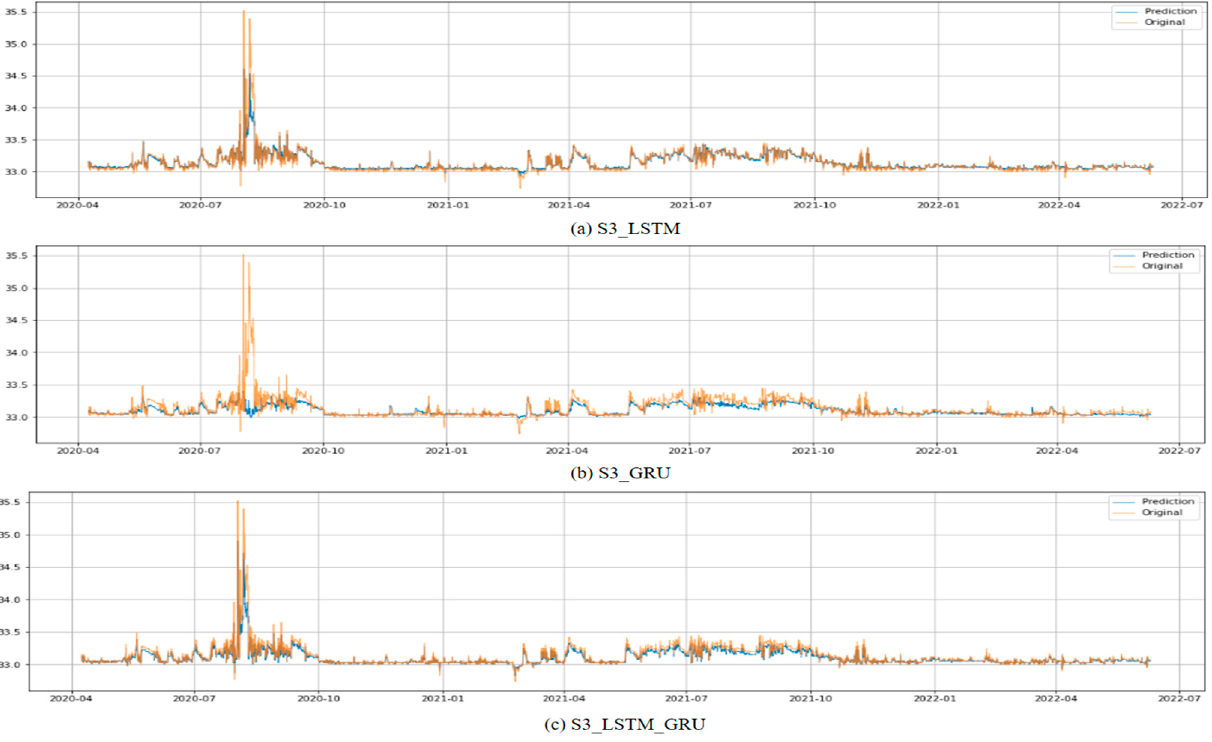
Figure 17. Comparison graph of observed and predicted values for each model in S3 case. ( a ) Multi-LSTM; ( b ) multi-GRU; and ( c ) LSTM–GRU.